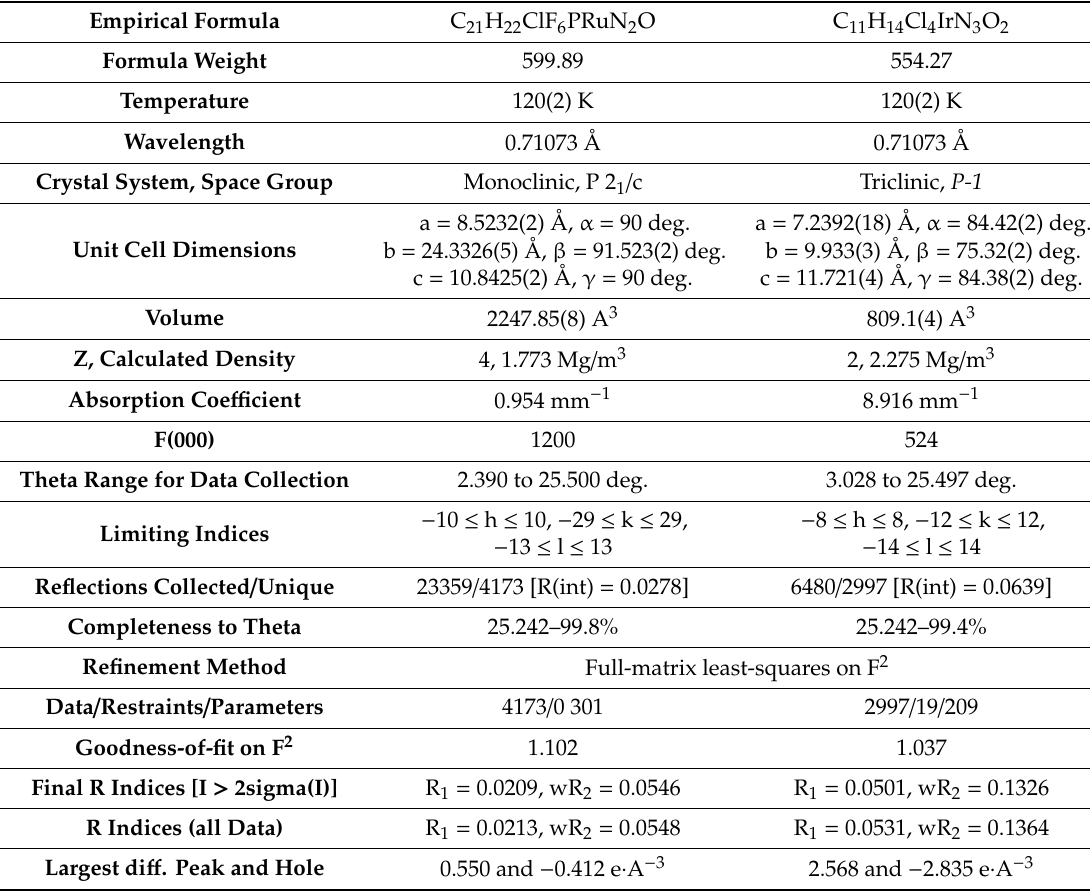
Table 1. Crystal data and structure refinement for 1 and 3